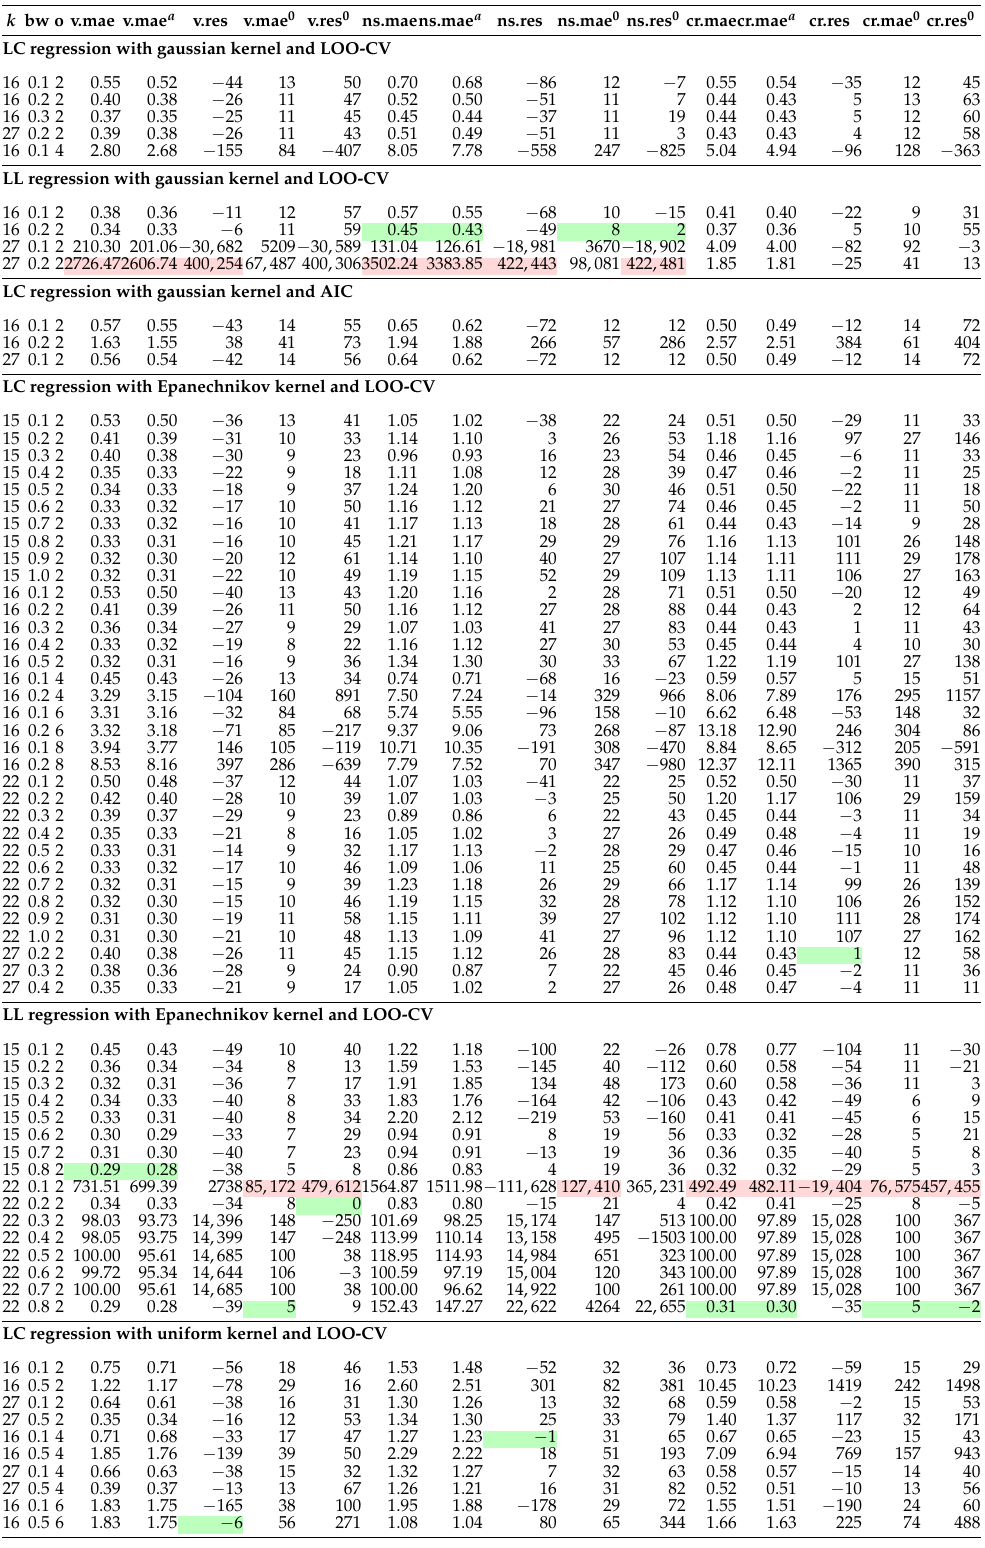
Table A35. Settings and out-of-sample validation figures of LC and LL proxy functions of BEL using basis function sets from Tables A33 and A34. Highlighted in green and red respectively the best and worst validation